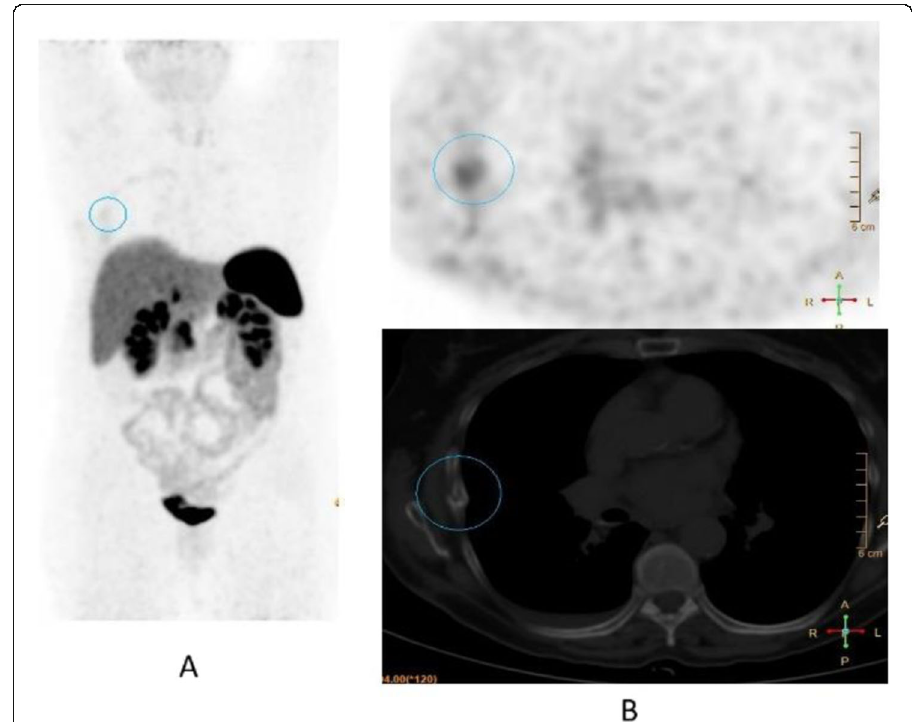
Fig. 56 68 Ga-DOTA peptide, restaging after surgery for lung carcinoid, specificity. Clinical history : 60 y.o. man; restaging after surgery for lung carcinoid. PET/CT findings : focal increased 68 Ga-DOTATOC uptake in a benign rib fracture ( a MIP, b PET and fused PET/CT, blue marker)